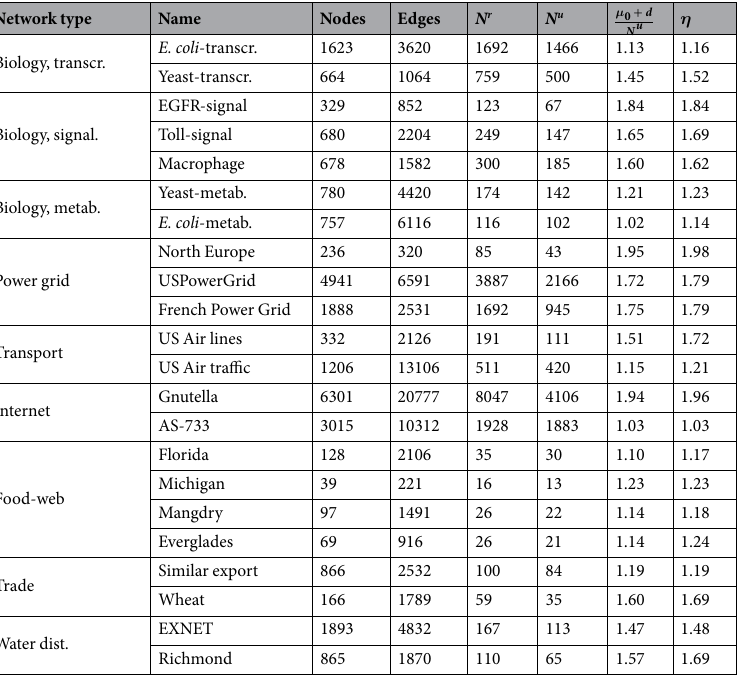
Table 3. Network characteristics and controllability results for the real-world networks considered in this paper. See SI for data sources. Just as for Erdős–Rényi networks and directed scale-free networks, η is in many cases close to the lower bound ( d + μ 0 )/ N u